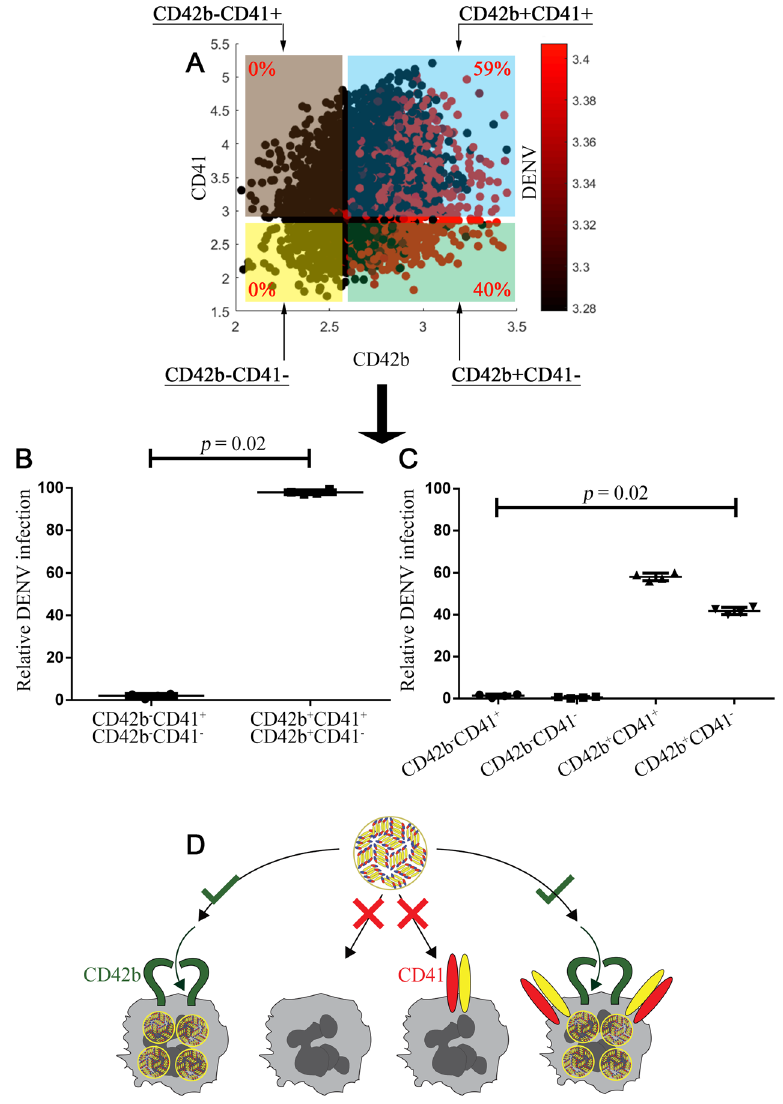
Figure 3. Requirement of CD42b in dengue virus infection. MEG-01 cells were infected with DENV (MOI = 0.5) for 2 hours and washed with PBS. The cultures were maintained in fresh medium for another 7 days before being triple immunostained. Flow cytometry standard data files were analyzed in three-dimension using custom-written software in MATLAB. All the fluorescence intensities were shown as log10 of the actual data. ( A ) Representative three-dimensional plot of surface CD42b, surface CD41 and intracellular DENV. ( B ) The relative DENV infection in CD42b − CD41 − / + and CD42b + CD41 − / + subpopulation (n = 4). ( C ) The relative DENV infection in CD42b − CD41 + , CD42b − CD41 − , CD42b + CD41 + and CD42b + CD41 − subpopulation (n = 4). Error bars represent mean ± SD. Statistical significance was determined by using the two-tailed Mann– Whitney test. ( D ) Proposed model for the requirement of CD42b in dengue virus